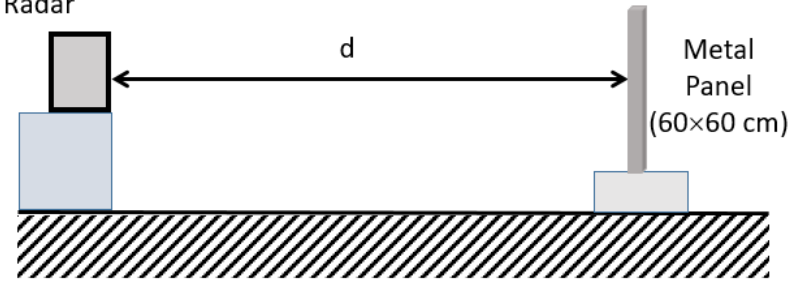
Figure 17. Sketch of the experimental investigated scenario.